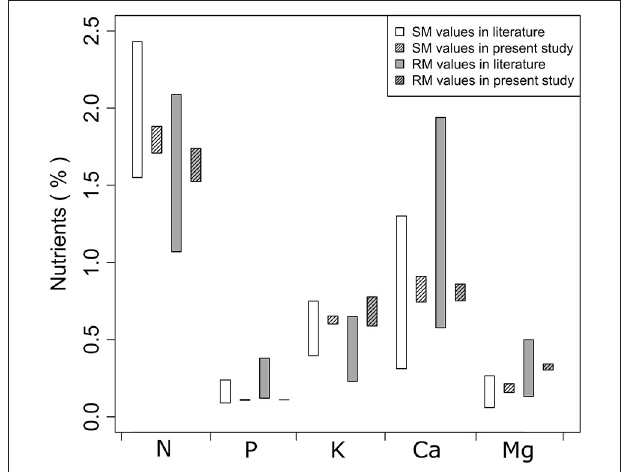
FIGURE 1 | Ranges of foliar N, P, K, Ca, and Mg concentrations in sugar maple (SM) and red maple (RM) seedlings that were measured in this study and were taken from the literature, i.e., based on St. Clair and Lynch (2005a,b), Park and Yanai (2009), Fahey and Blum (2011), and Momen et al.